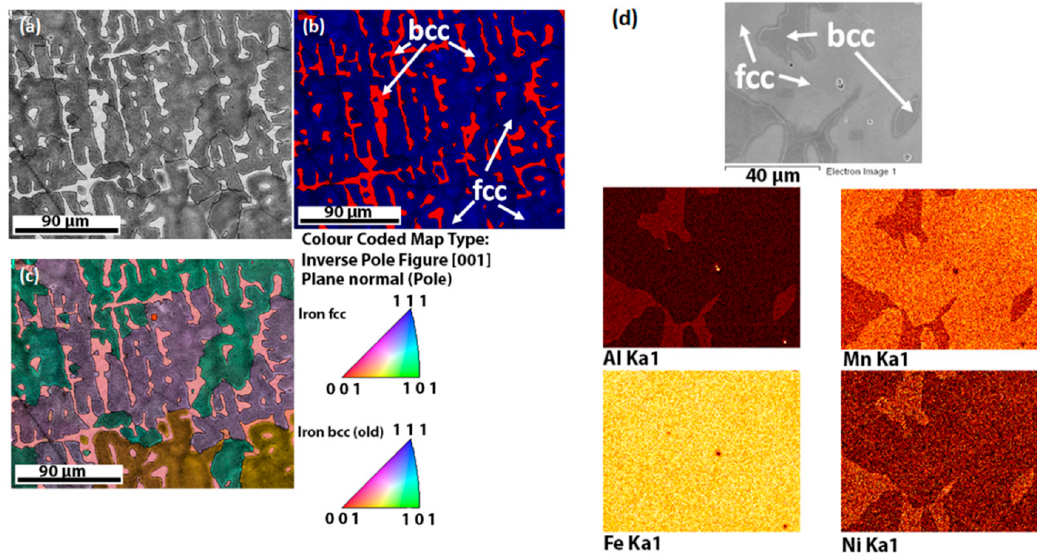
Figure 11. Microstructure of the as-cast sample, ( a ) BE (Backscattered electron) image, ( b ) EBSD (Electron Backscatter Diffraction) phase analysis ( c ) IPF-Z (Inverse Pole Figure–Z axis) analysis ( d ) EDS (Energy-dispersive X-ray spectroscopy) elemental mapping of Al, Mn, Fe, and Ni.